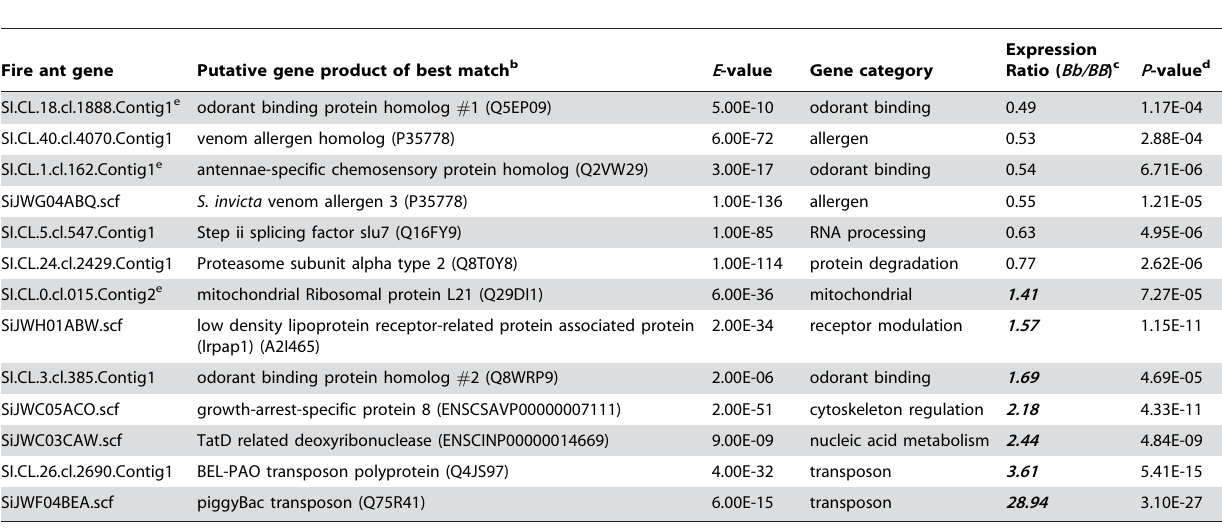
Table 1. Genes differentially expressed between polygyne S. invicta workers bearing Gp-9 genotypes Bb and BB that significantly match annotated genes in public databases a